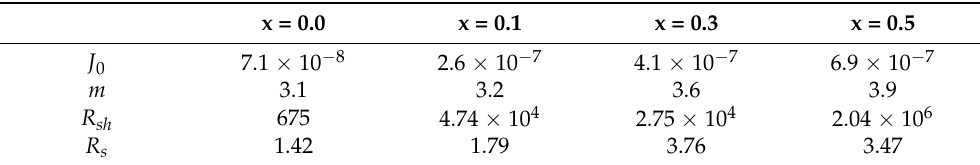
Table 2. The measured parameters such as J 0 , m , R sh , and R s for the devices fabricated at various x under